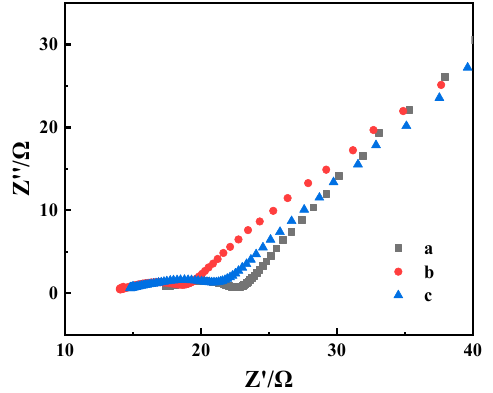
Figure 5. Nyquist plots ( − Z” vs. Z’) of Nafion/OMC-COOH (a), Nafion/GOx/OMC-COOH (b), and Nafion/GOx-NH 2 /OMC-COOH (c).